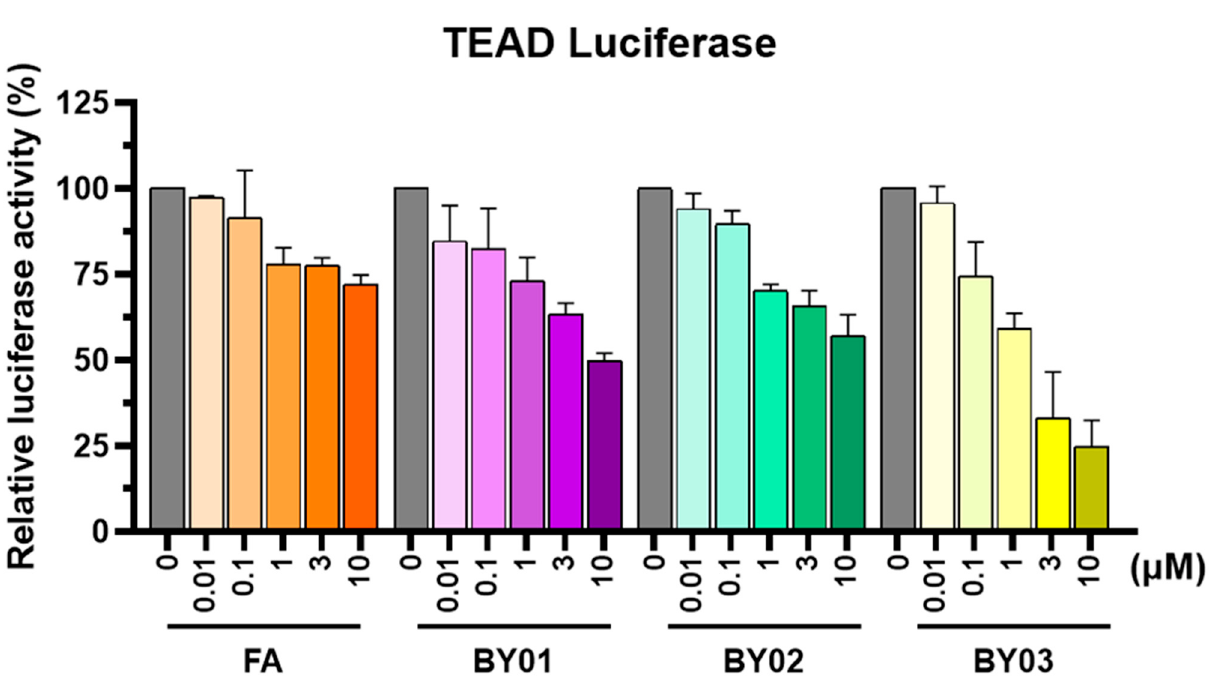
Figure 6. TEAD reporter luciferase activity observed in A375 cells treated with 10 nM to 10 µ M of hit compounds with FA (flufenamic acid) 24 h post-transfection ( n = 3).